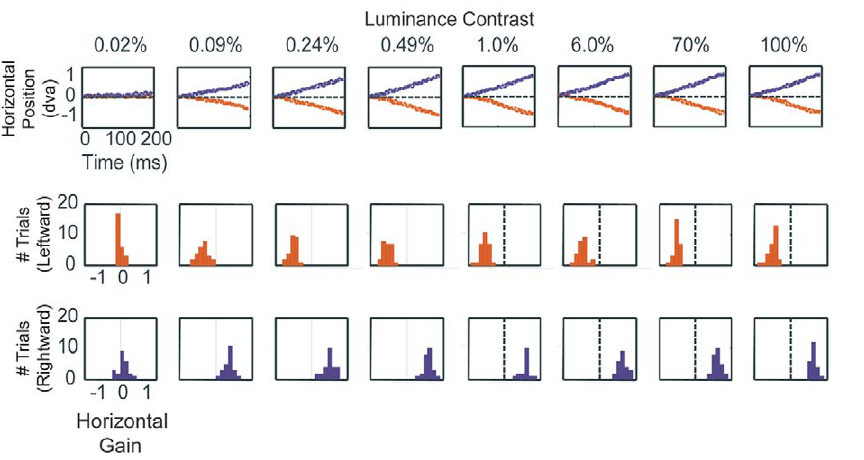
Figure 2. Responses to a Single Pattern of Varying Contrast. The top row of panels depicts average eye position over 200 ms starting at the end of the saccade for Monkey A, for 8 different contrasts, when the aperture was in the left hemifield. The blue lines are eye movement traces averaged across all trials on which the pattern moved to the right, while the red lines are average traces for leftward stimuli. The 2 rows of panels below show the distributions of horizontal gain of each individual trial, at each level of contrast for rightward stimulus motion (red histograms) and leftward stimulus motion (blue histograms). The point of gaze followed the motion of the pattern for all but the lowest contrast (for each contrast of 0.09% – 100%: two-tailed t-test, p , 0.001; 0.02%: two-tailed t-test, p . 0.05, n.s.).